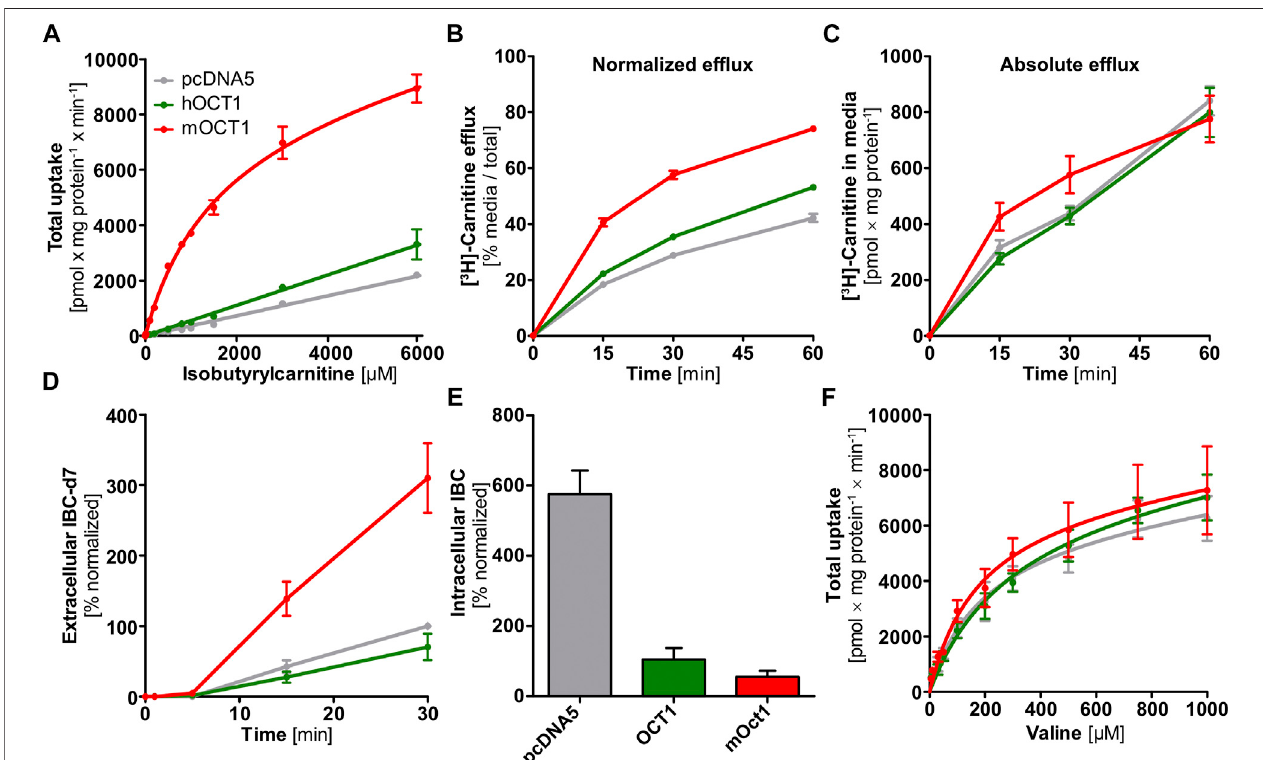
FIGURE 3 | In vitro uptake and ef fl ux experiments with carnitine, isobutyrylcarnitine, or valine. (A) In contrast to HEK293 cells overexpressing mOCT1, hOCT1 did notshowuptakeofIBCsigni fi cantlyabovetheuptakeseeninempty-vectorcontrolcells(pcDNA5). (B) HEK293cellsoverexpressingmOCT1showedincreasedef fl uxof radiolabeled carnitine, compared to hOCT1 and empty vector control (pcDNA5) when calculated in relation to total carnitine in medium and cells. (C) Absolute carnitine ef fl uxdidnotdifferbetweencellsoverexpressinghOCT1andemptyvectorcontrolandalsowithmOCT1therewasamoderateeffectonly. (D) Ef fl uxofIBC-d7was observed after incubation with valine-d8 only for mOCT1. (E) Intracellular IBC concentrations under regular culturing conditions depended strongly on the overexpression of OCT1 and are higher without hOCT1 or mOCT1 ( p < 0.0001, one-way ANOVA with Tukey post-hoc test). (F) Valine was studied as the precursor of IBC,ValineuptakebymouseandhumanOCT1compared toempty-vector controlcellline(pcDNA5). (A – F) Dataarerepresented asthemean ± SEMfromatleastthree independent experiments. Total uptake implies the intracellularly accumulated substance normalized by total protein and time, without subtraction of uptake into empty vector-overexpressing cell line “ pcDNA5 ”